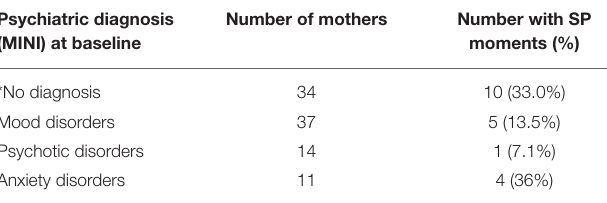
TABLE 3 | Maternal psychiatric illness and